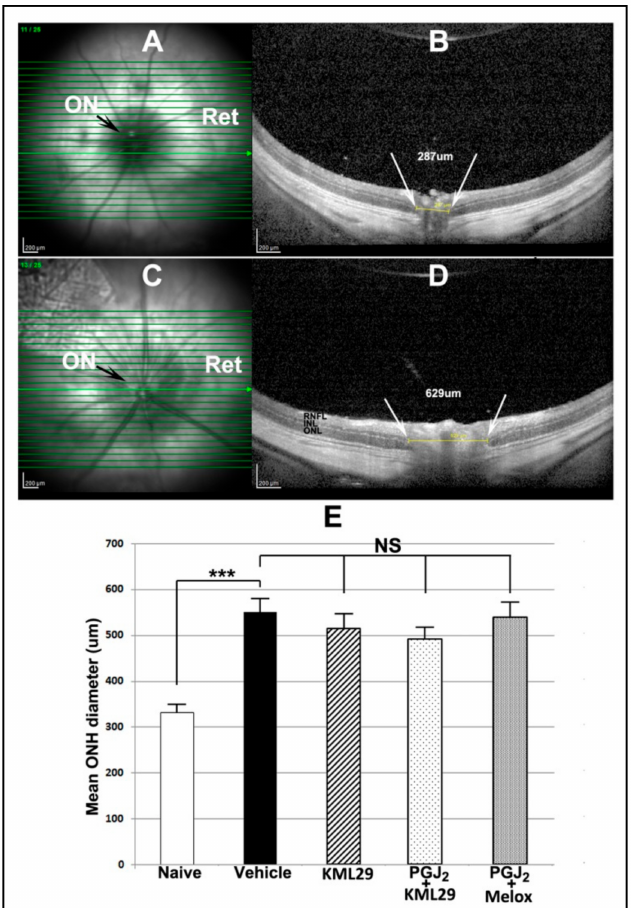
Figure 4. SD-OCT-ONH cross-sectional comparison and mean values for different treatment groups. ( A , C ): en face views of the optic disk in A) naïve (uninduced) and C) induced vehicle–treated eye. The uninduced eye in A shows a small, dark optic disk (ON), while the induced eye in C has a swollen, edematous disk (ON). ( B , D ): Cross-sectional views of the same optic disks seen in A and C, respectively. B. The uninduced eye has a relatively narrow ONH cross-sectional diameter (287 um) as measured between the two edges of the inner nuclear layer (INL) (shown as white arrows in B) in this particular slice. D. The induced eye in shows ONH edema with expansion of the INL–INL distance. Mean ONH diameter is defined as the mean of the three slices with the largest INL–INL distance. ( E ): Mean ONH diameters of naïve (white bar), vehicle (black bar), KML29 alone (MAGL inhibitor) (cross-hatched bar), PGJ 2 and KML29 combination (light speckle), and PGJ 2 and meloxicam (Melox) combination. There is a significant expansion of the mean ONH diameter following induction (331.3 ± 8.7 um naïve ( n = 11) vs. 550.5 ± 22.3 um vehicle ( n = 11) (sem); (***; significant > p < 0.001) p = 0.0002; Mann–Whitney two-tailed test). Comparisons between all induced groups were nonsignificant (NS) ( p >